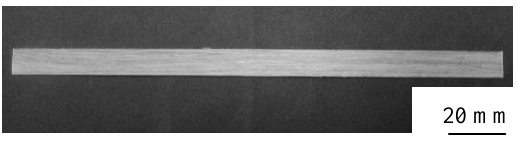
Figure 1. Survey photograph of Manila hemp fiber reinforced biodegradable plastics (MHFRP) specimen.